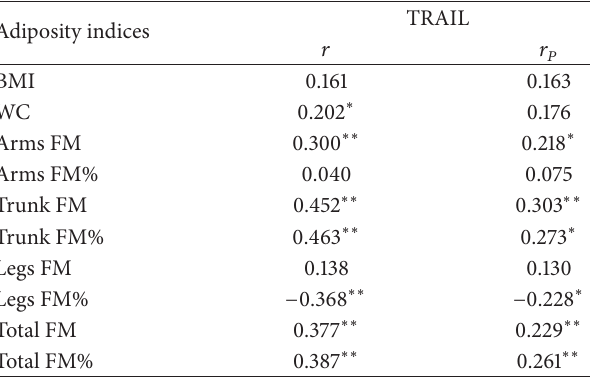
Table 2: Simple and partial Pearson’s correlation coefficients of serum TRAIL and anthropometric and DXA-derived indices of adiposity.